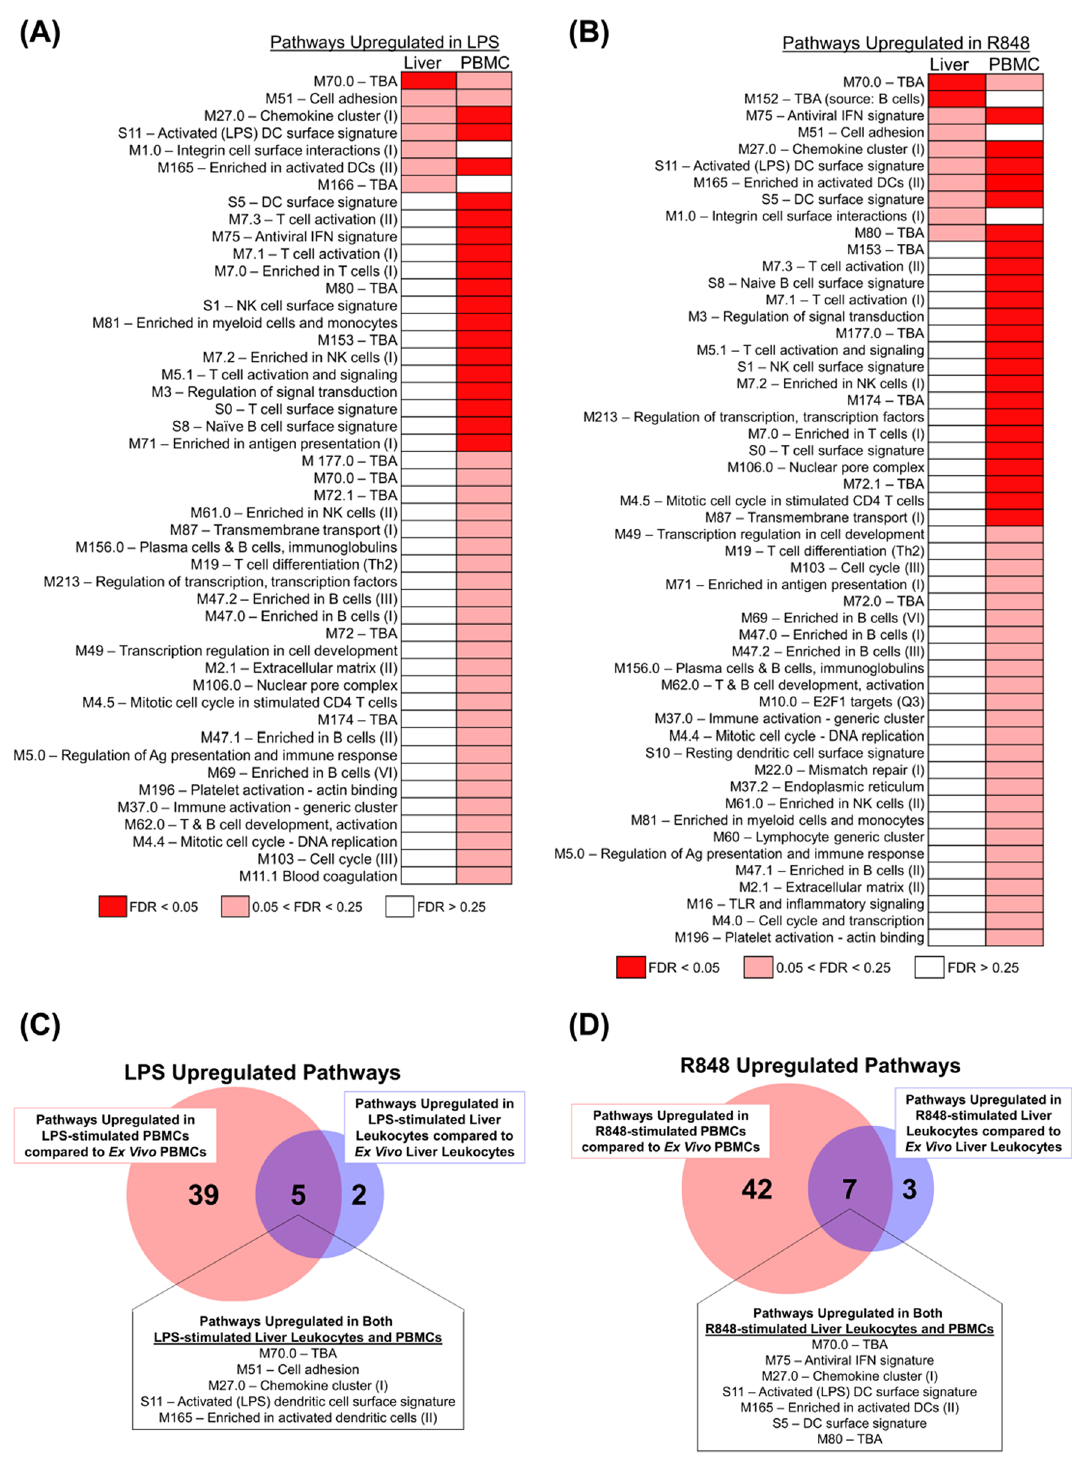
Figure 4. Fewer gene pathways are upregulated in stimulated LMCs than matched PBMCs. (A) Differential modulation of molecular pathways from the blood transcriptome modules (BTM) of ex vivo LMCs versus LPS-stimulated LMCs was compared to the modulation of molecular pathways from the same BTM pathways of ex vivo PBMCs versus LPS-stimulated PBMCs, analyzed by GSEA. (B) Differential modulation of molecular pathways from the BTMs of ex vivo LMCs versus R848-stimulated LMCs was compared to the modulation of molecular pathways from the same BTM pathways of ex vivo PBMCs versus R848-stimulated PBMCs, analyzed by GSEA. Pathways that were had a false discovery rate (FDR) of less than 0.05 are in red, between 0.05 and 0.25 FDR in pink, and greater than 0.25 FDR in white. (C) Shared BTM pathways upregulated with a FDR < 0.25 in both LPS-stimulated LMCs versus ex vivo LMCs and LPS-stimulated PBMCs versus ex vivo PBMCs. Leading edge genes driving these pathways are listed in Supplementary Table 2. (D) Shared BTM pathways upregulated with a FDR < 0.25 in both R848-stimulated LMCs versus ex vivo LMCs and R848-stimulated PBMCs versus ex vivo PBMCs. Leading edge genes driving these pathways are listed in Supplementary Table